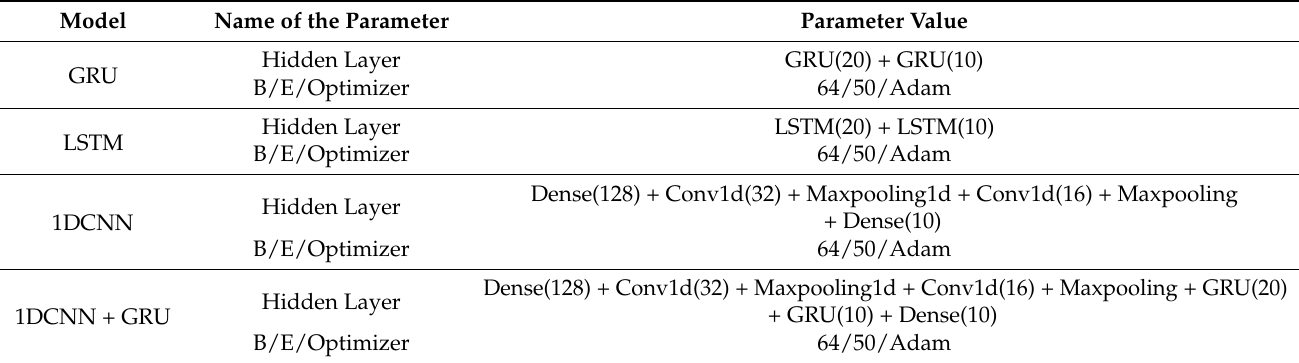
Table 2. Example of toll station flow data.